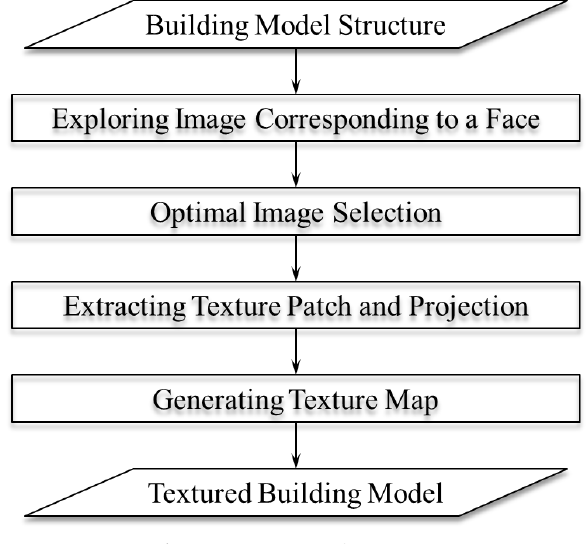
Figure 10. Process of texturing.